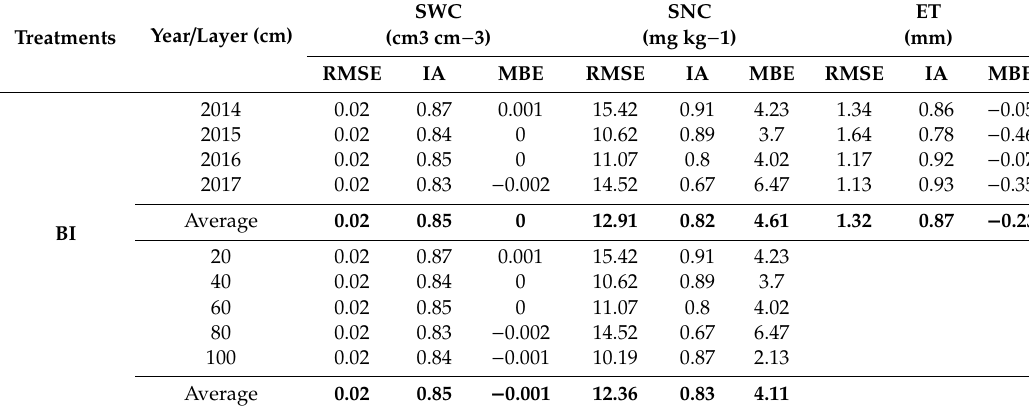
Table 6. Statistical indices: RMSE (root mean square error), IA (index of agreement) and MBE (mean bias error) for predicted SWC (soil water contents) and SNC (soil NO - -N content) at different depths and ET (evapotranspiration) under film mulching border irrigation (BI) and film mulching drip irrigation (DI). SWC SNC ET (cm3 cm − 3) (mg kg − 1) Treatments Year / Layer (cm) Treatments RMSE IA MBE RMSE MBE RMSE IA MBE 2014